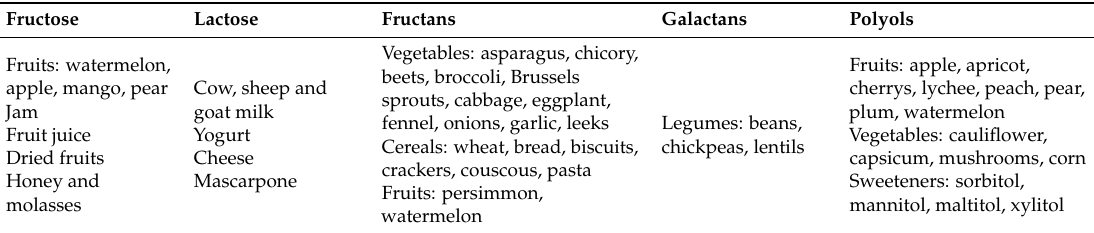
Table 7. Main high FODMAPs foods.